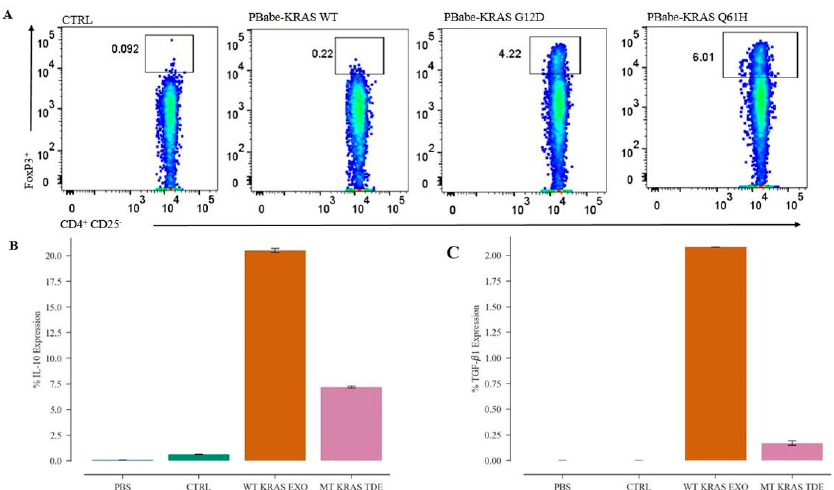
Figure 3. MT KRAS cDNA, in the absence of other biomolecules, is sufficient to convert T cells to Tregs. ( A ) Naïve CD4 + CD25 − T cells were transfected with plasmid PBabe-KRAS WT, PBabe-KRAS G12D, or PBabe-KRAS Q61H MT, and the percentage of CD4 + FOXP3 + cells was determined by flow cytometry. Data from the four independent donor samples are shown as a representative flow cytometry dot plot obtained by gating total viable CD4 + or CD4 + naïve T cells transfected with the WT or MT KRAS plasmid. ( B , C ) Attune NXT flow cytometry was used to evaluate percent expression of